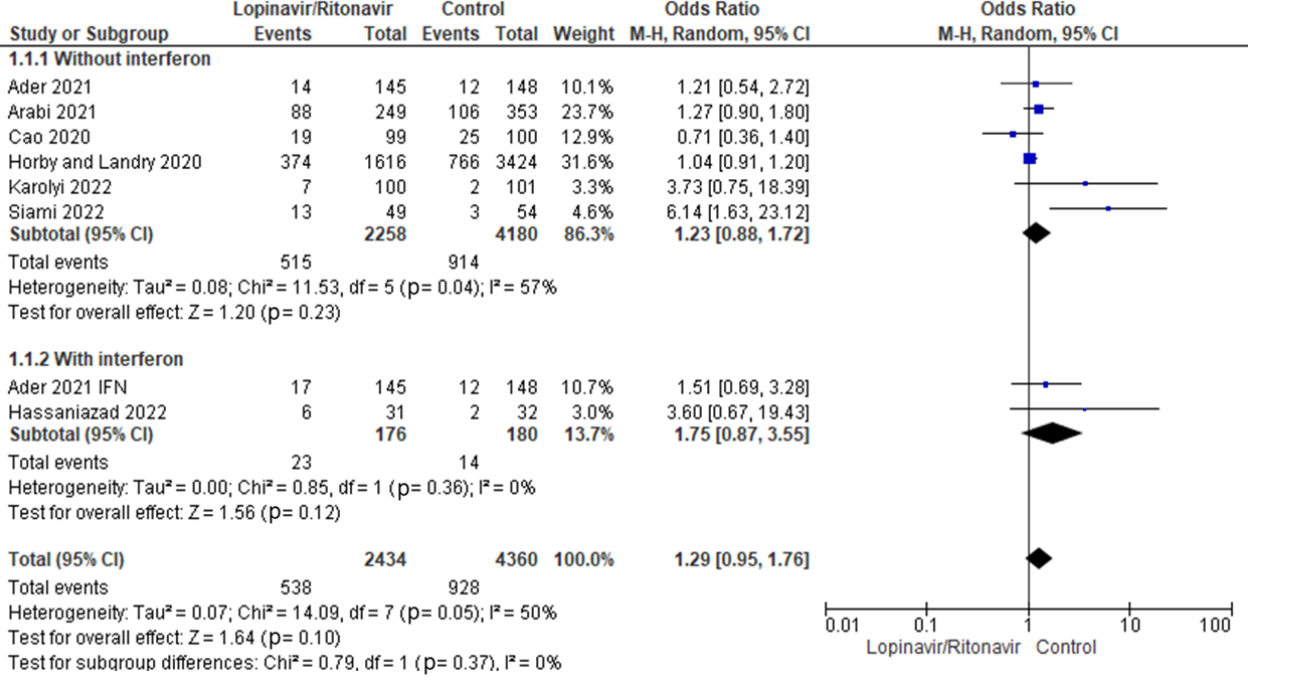
Figure 8. Subgroup analysis for mortality rates. The sizes of the blue squares reflect the relative weight of the individual trials. The combined point estimates are shown as black diamonds. The diamonds and squares (together with the 95% CIs) located beyond the vertical line (indicating the unit value) show that a result was statistically significant.